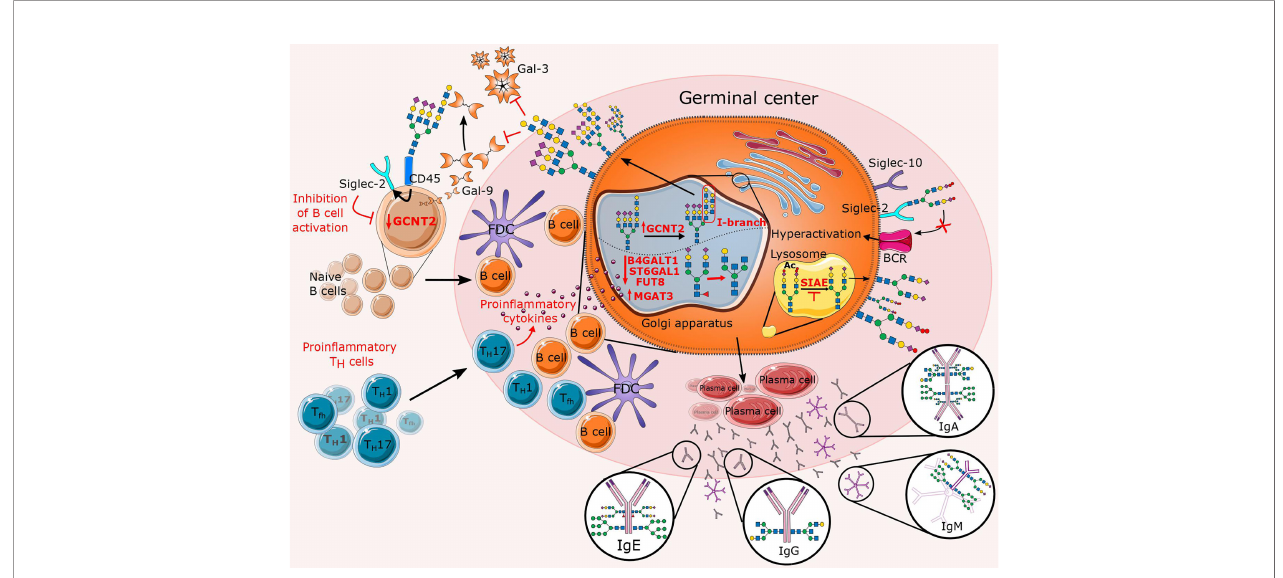
FIGURE 5 | Overview of altered N-glycosylation pathways regarding B cells during chronic in fl ammation. In the presence of proin fl ammatory stimuli, in fl ammatory T cells signi fi cantly affect B cell proliferation and their N-glycan pro fi le by deregulating a speci fi c subset of glycosyltransferases (B4GALT1, ST6GAL1, FUT8, MGAT3, and GCNT2). The latter is re fl ected in an increase in features such as bisecting GlcNAc, agalactosylation, afucosylation, and the presence of I-branches that have been shown to inhibit Gal-3 and Gal-9 binding. In addition to the affected Golgi enzymes, lysosomal sialic acid acetyl esterase (SIAE) is also downregulated so that it is unable to deacetylate sialic acids, which is necessary for immunomodulation of B cell receptor (BCR) signaling. This fi gure also summarizes the Fc N-glycome of secreted immunoglobulins, which re fl ects in fl ammation-related changes that may further contribute to disease